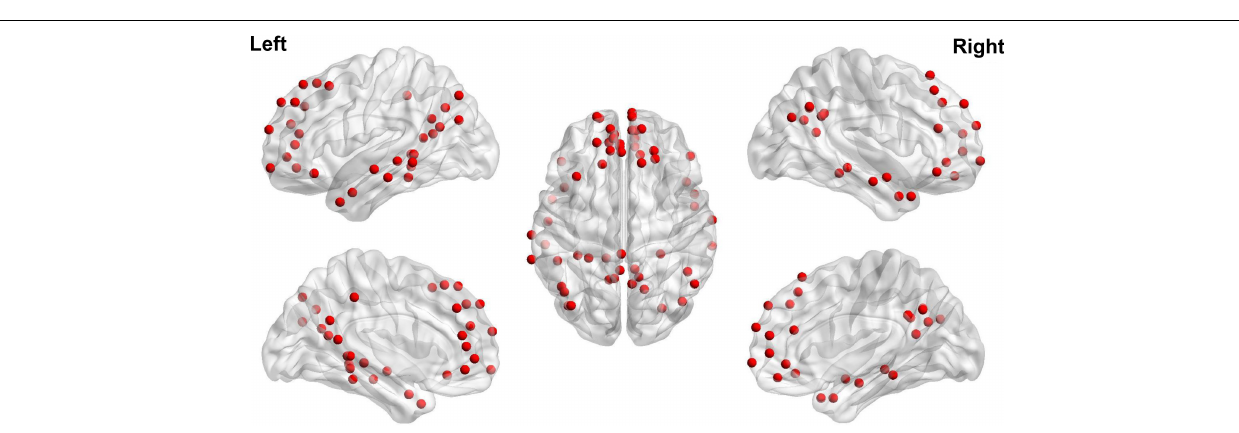
FIGURE 2 | Regions of interest used to define the DMN based on Power et al.